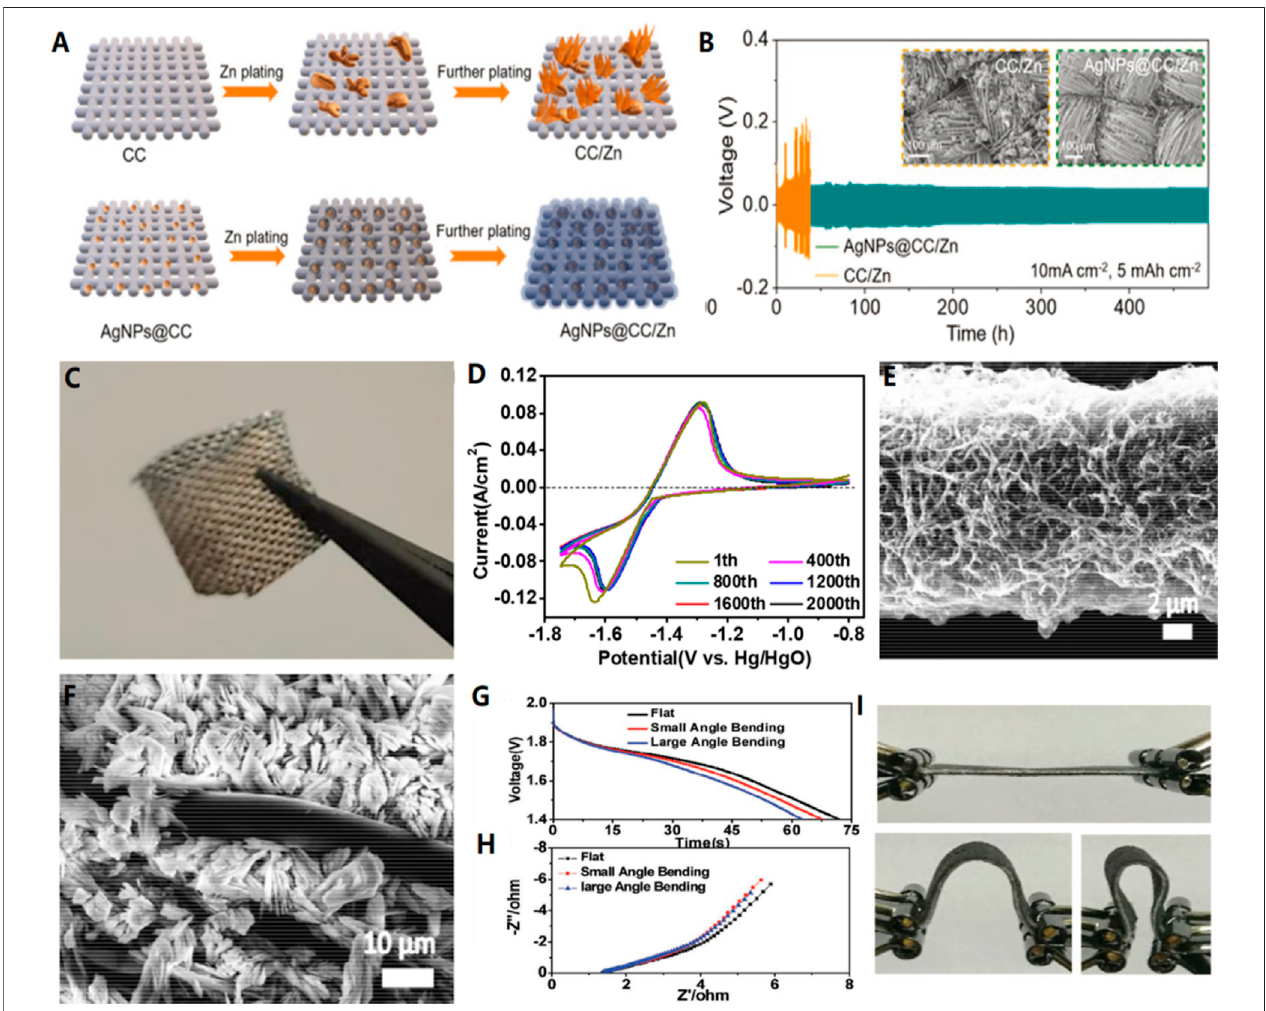
FIGURE1|(A) SchematicdiagramofZndepositiononbareCCandAgNPs@CCscaffolds. (B) Thecapacityis5 mA h/cm 2 at10 mA h/cm 2 currentdensity.Inset: SEM images ofCC/Zn and AgNPs@CC/Zn electrodes after circulation. (C) Flexible AgNPs@CC/Zn electrode under bending.Copyright 2021 Wiley-VCH GmbH. (D) CV curves ofthe CC-CF@120ZnO at different cycles. SEM images of (E) CC-CF@ZnO and (F) CC-ZnO after cycling test, showing the importance of CFs for preventing the Zndendritegrowth. (G – I) DischargecurvesandEISresultsofsolid-statebatteriesunderdifferentbendingconditions.Copyright2016WILEY-VCHVerlagGmbH& Co. KGaA,